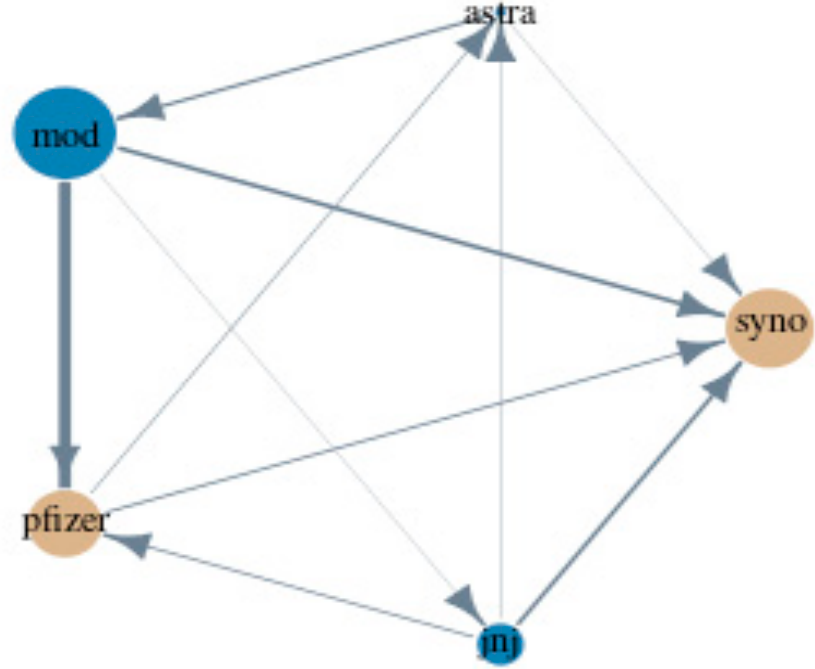
Figure 1. Volatility transmission diagram. Note: The brownish yellow color indicates a net volatility receiver, whereas the darkish blue color shows a volatility contributor. The thickness of the lines indicates the magnitude of the volatility transmission.